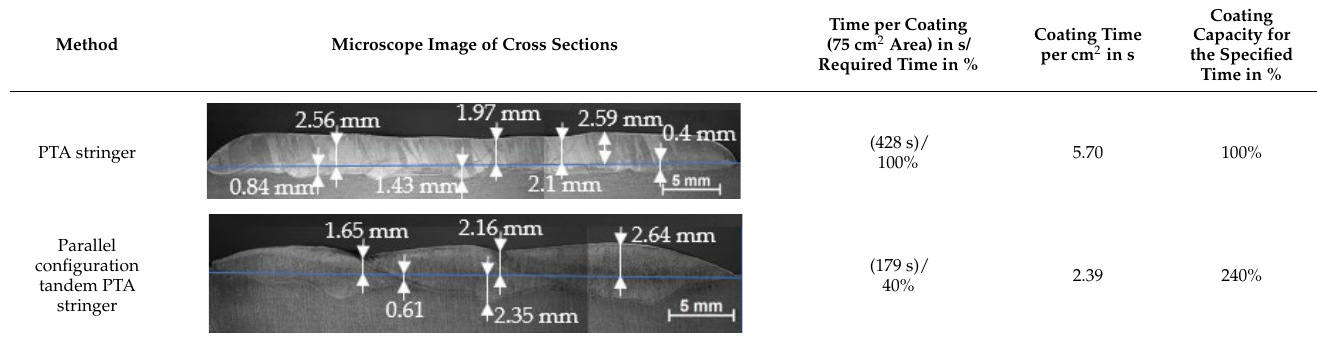
Table 7. Multi-material coating is applied by the series configuration torches.